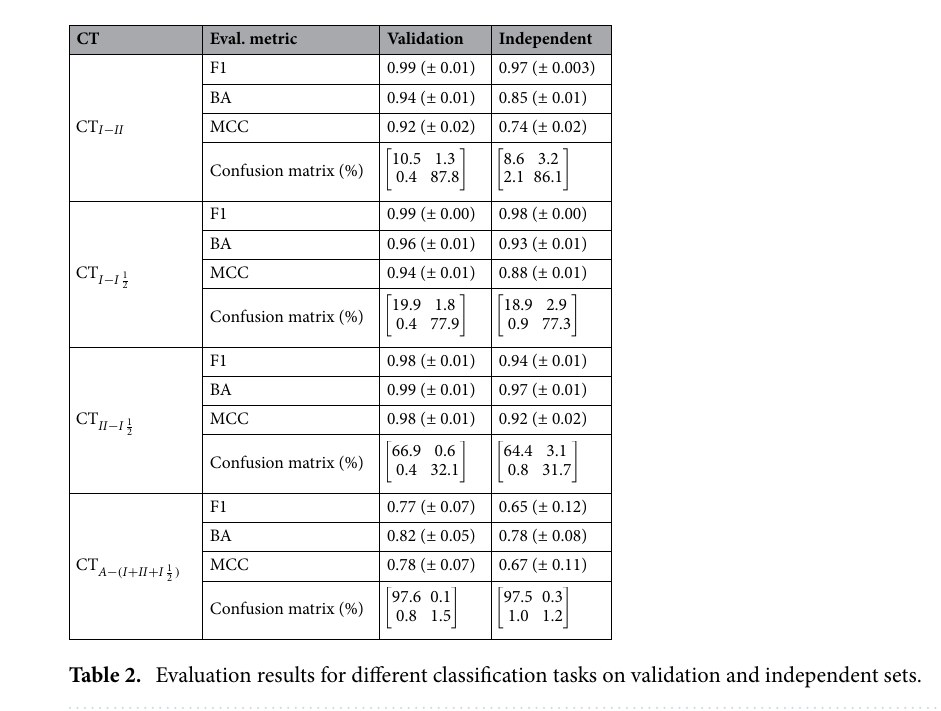
I 1 2 , the F1 value was −